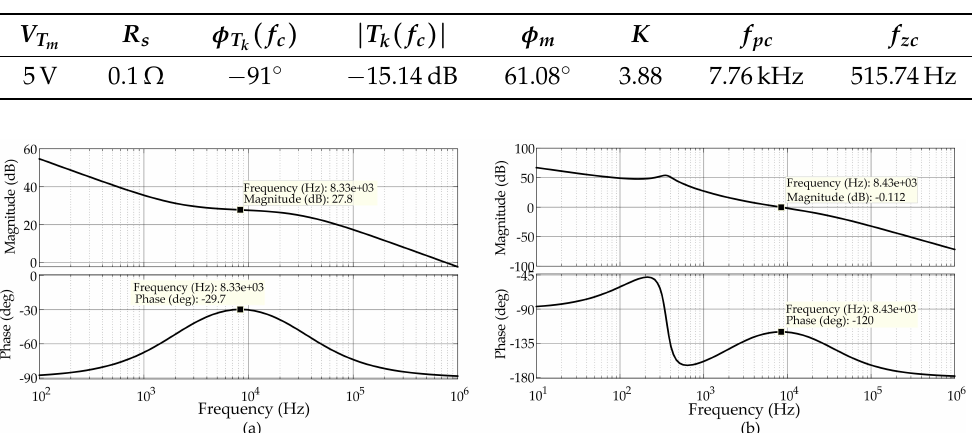
Table 6. Parameters of the ISLC with GCF = 2 kHz.